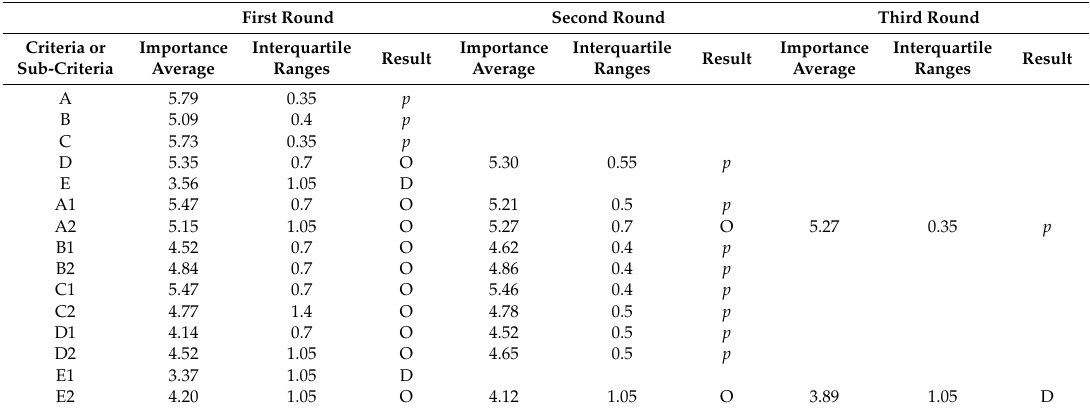
Table 4. Integration of interquartile ranges and importance of categorized criteria and sub-criteria based on the modified Delphi method (MDM). Second Round Third